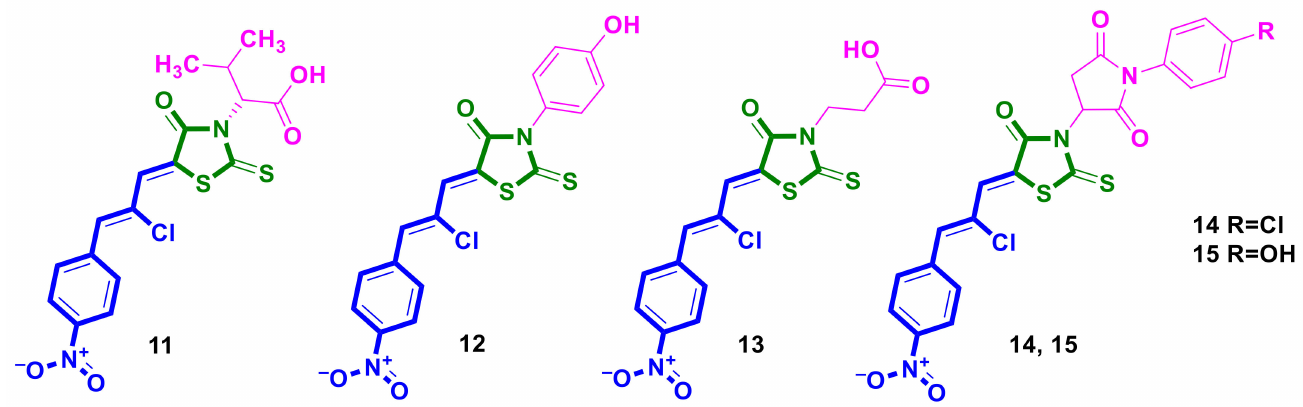
Figure 6. Ciminalum–4-thiazolidinone hybrid molecules as potential anticancer